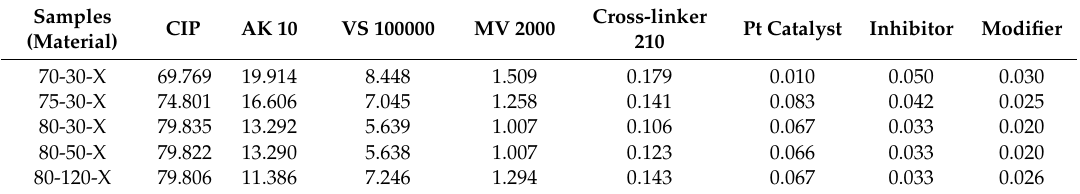
Table 1. Proportions of individual components for fabrication of the MAE samples in mass